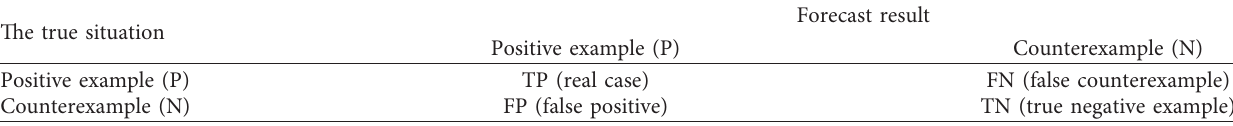
Table 1: Confusion matrix of classification results.